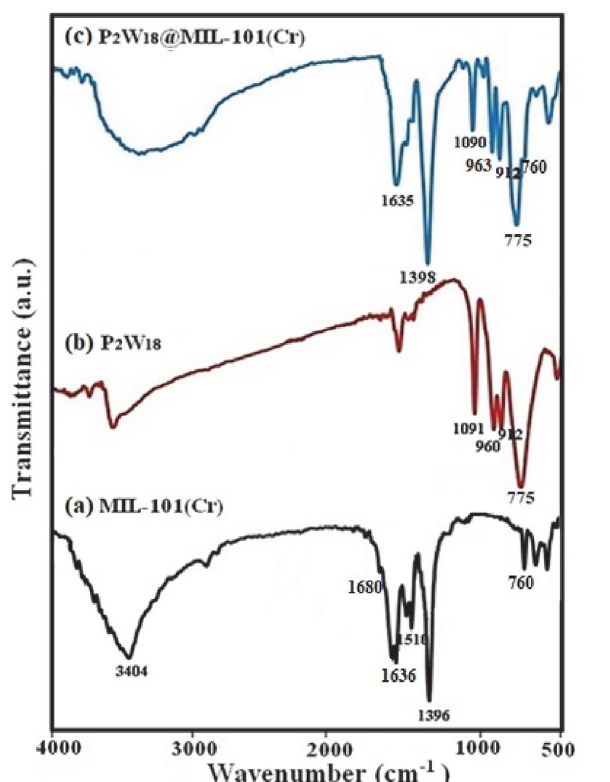
Figure 1. FT-IR spectra of (a) MIL-101 (Cr), (b) P 2 W 18 and (c) P